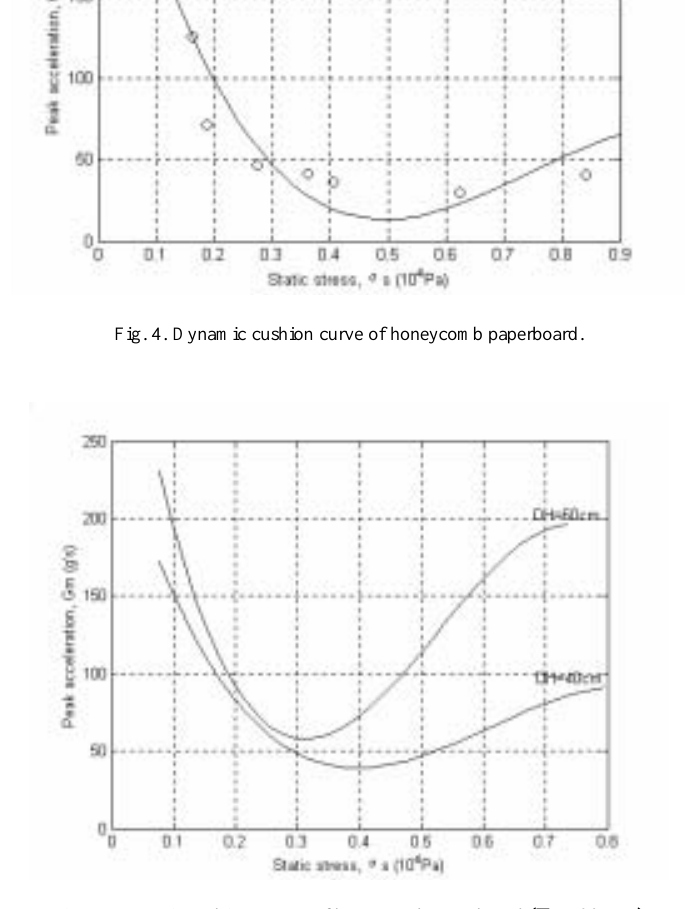
Fig. 5. Dynamic cushion curves of honeycomb paperboard ( T = 20